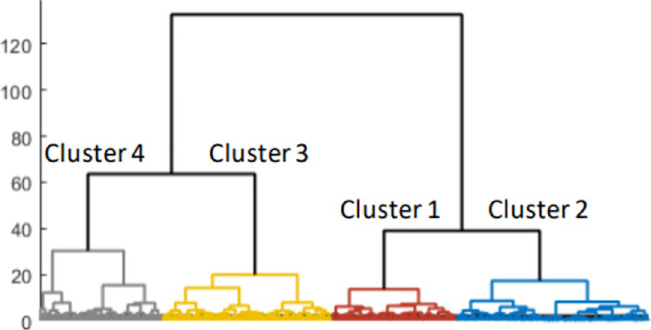
Fig 2. Clustering results employing the resultant vector-valued Wasserstein distance on METABRIC data.